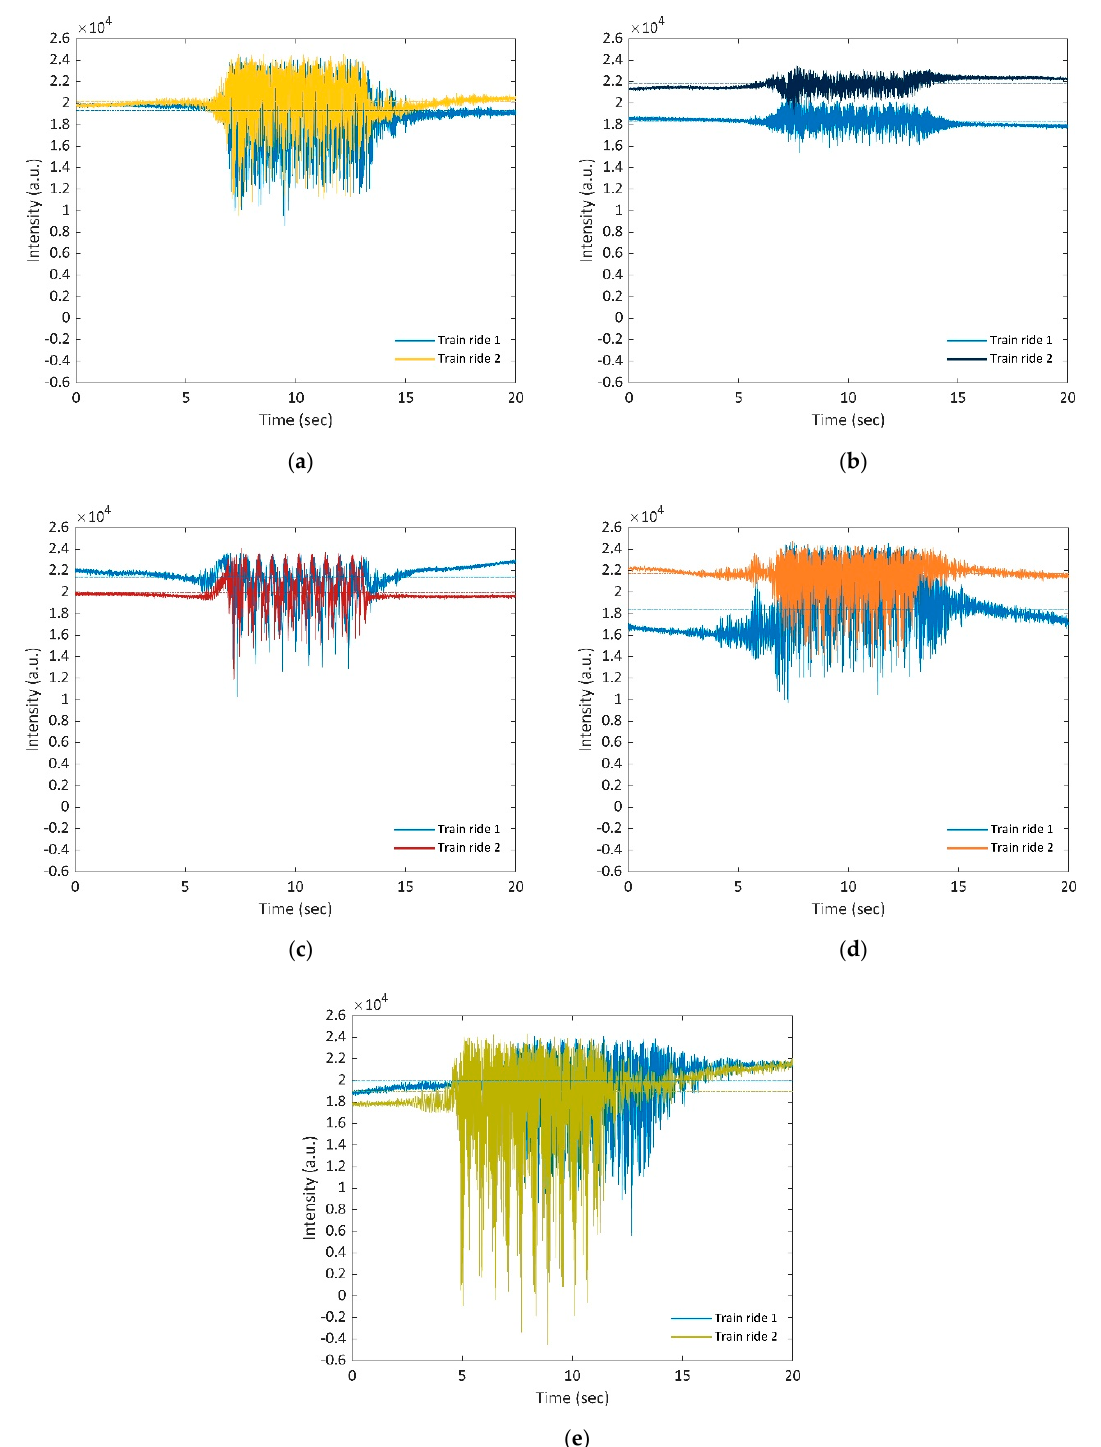
Figure 5. Raw backscattered signal of two train rides in the same train composition on the same day in different channels (locations). ( a ) Channel 300; ( b ) Channel 325; ( c ) Channel 350; ( d ) Channel 375; ( e ) Channel 399.